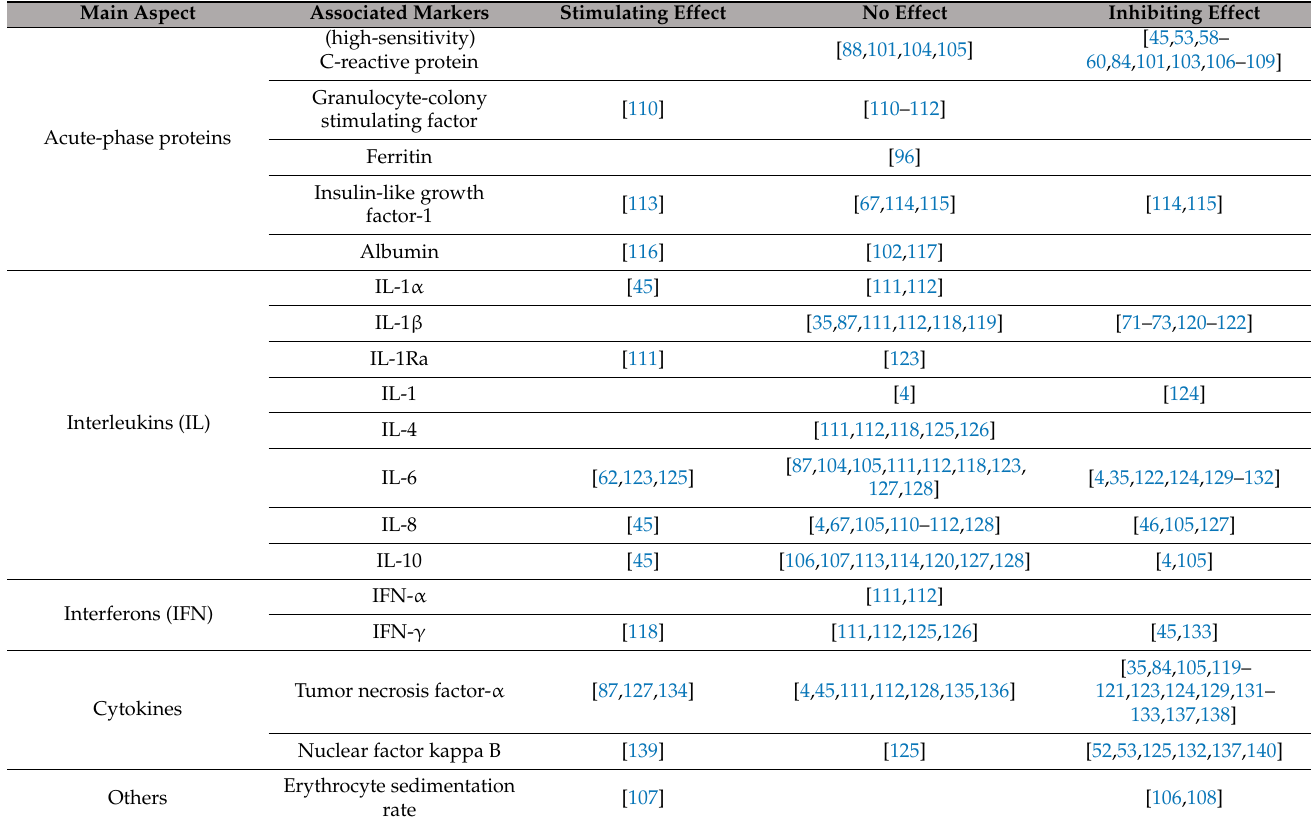
Table 2. The effect of HBOT on inflammation markers.